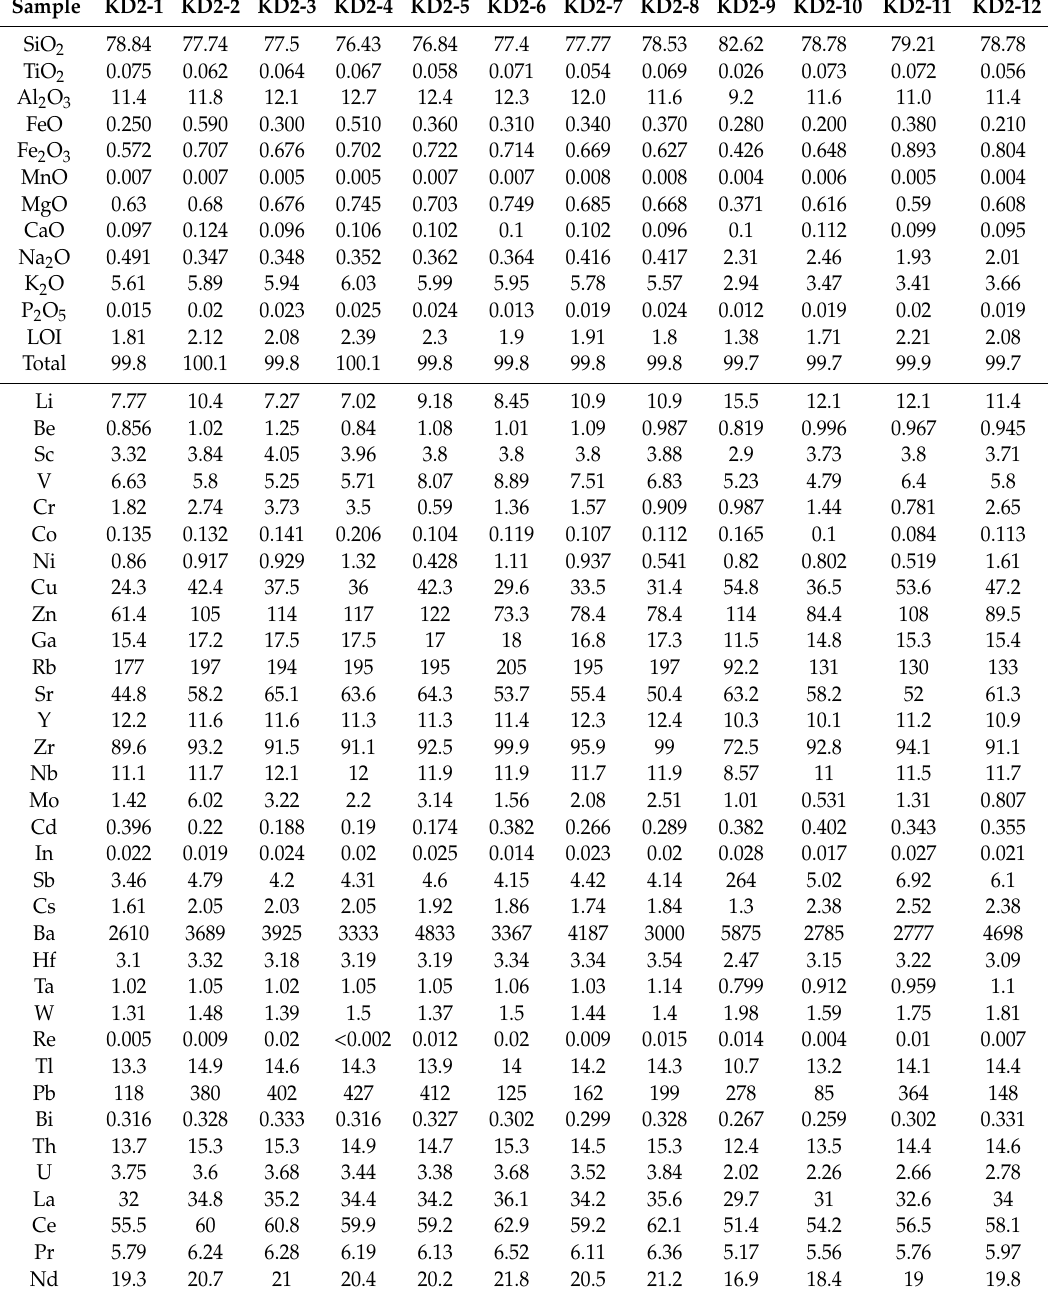
Table 2. Whole rock major and trace element data of the ore-hosting rhyolitic tu ff in the Kendenongshe polymetallic